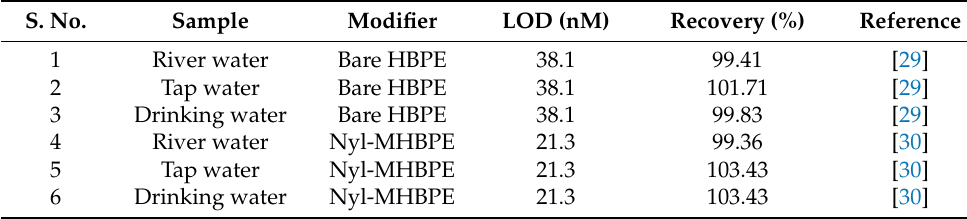
Table 2. Determination of lindane using water